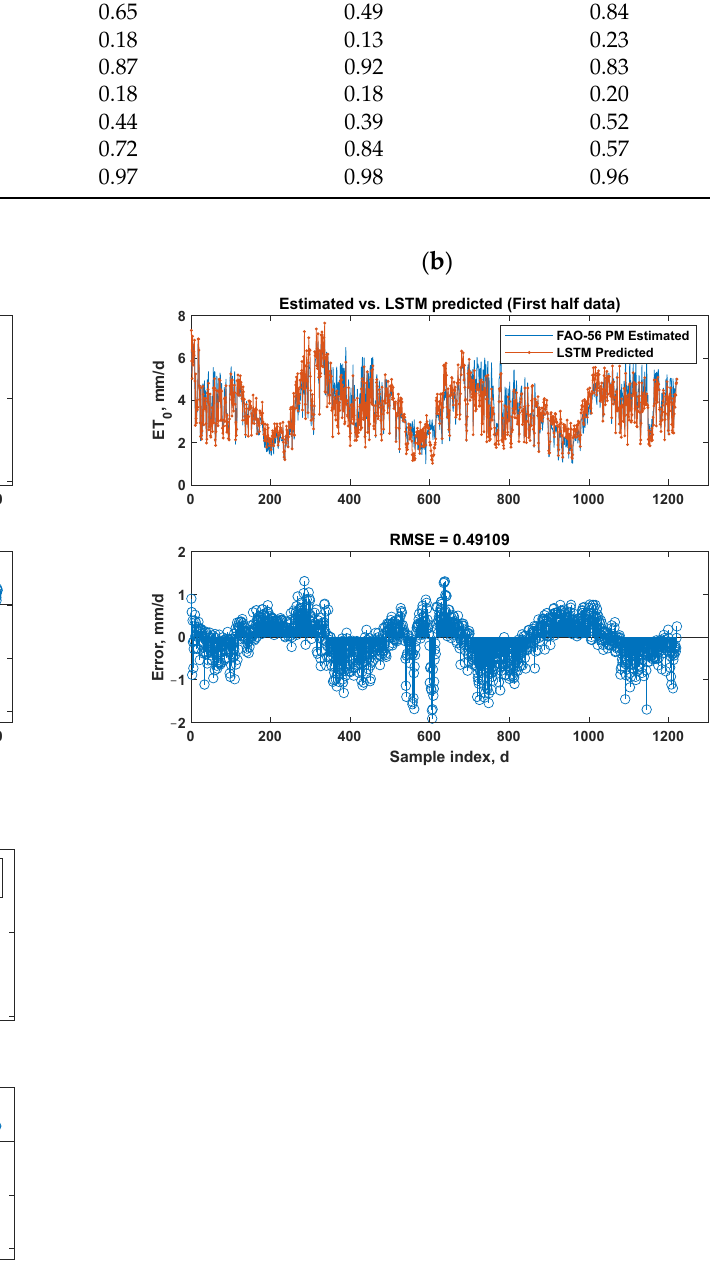
Table 13. Performance of the LSTM model for predicting daily ET 0 values on the Ishurdi dataset. Performance Indices